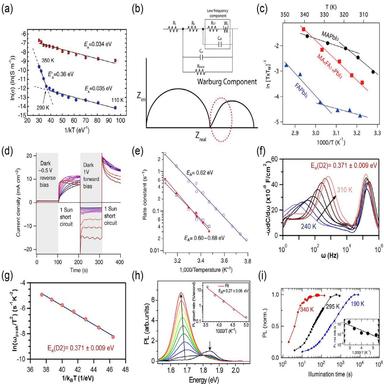
(a) Temperature-dependent conductivity of the MAPbI3 film under dark (blue) and illumination (red). Copyright 2015, Wiley-VCH GmbH. (b) Typical Nyquist plot for mixed conductor system. Inset: equivalent circuit diagram of PSCs. (c) Arrhenius-like plot of 1/(TTW) versus T1 for MAPbI3, FAPbI3, and MAxFA1xPbI3. Copyright 2015, American Chemical Society. (d) Temperature-dependent chronophotoamperometry measurements of a MAPbI3-based cell. (e) Calculation of Ea by transient photocurre